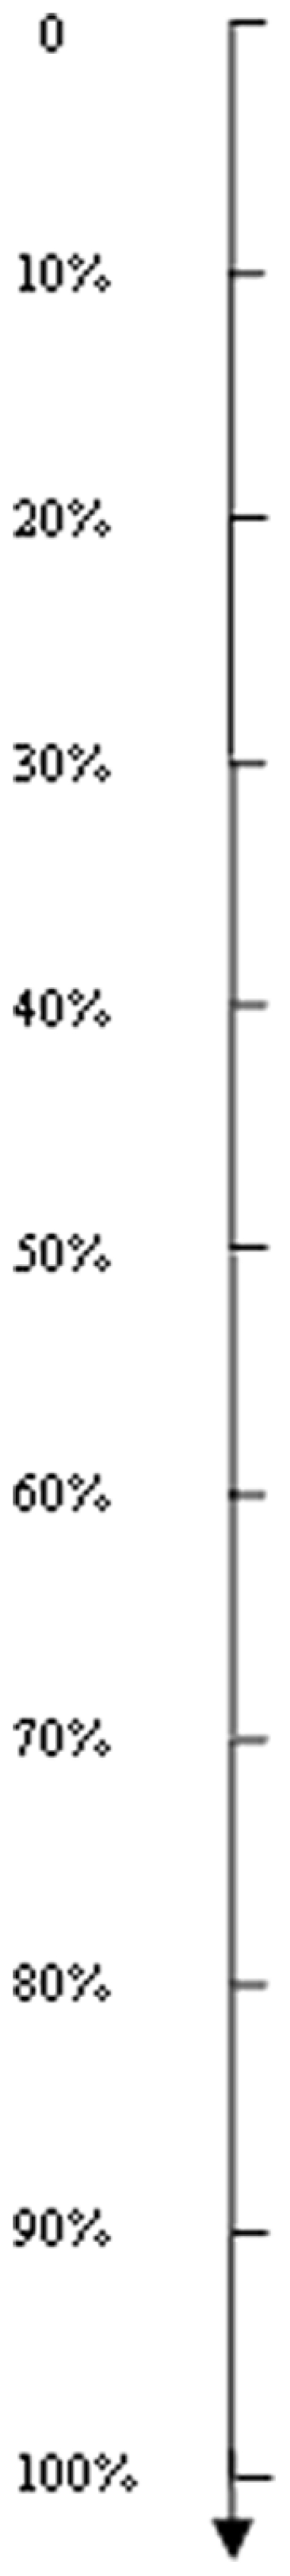
The down-version of the response scale for the ranking question in Experiment 3.